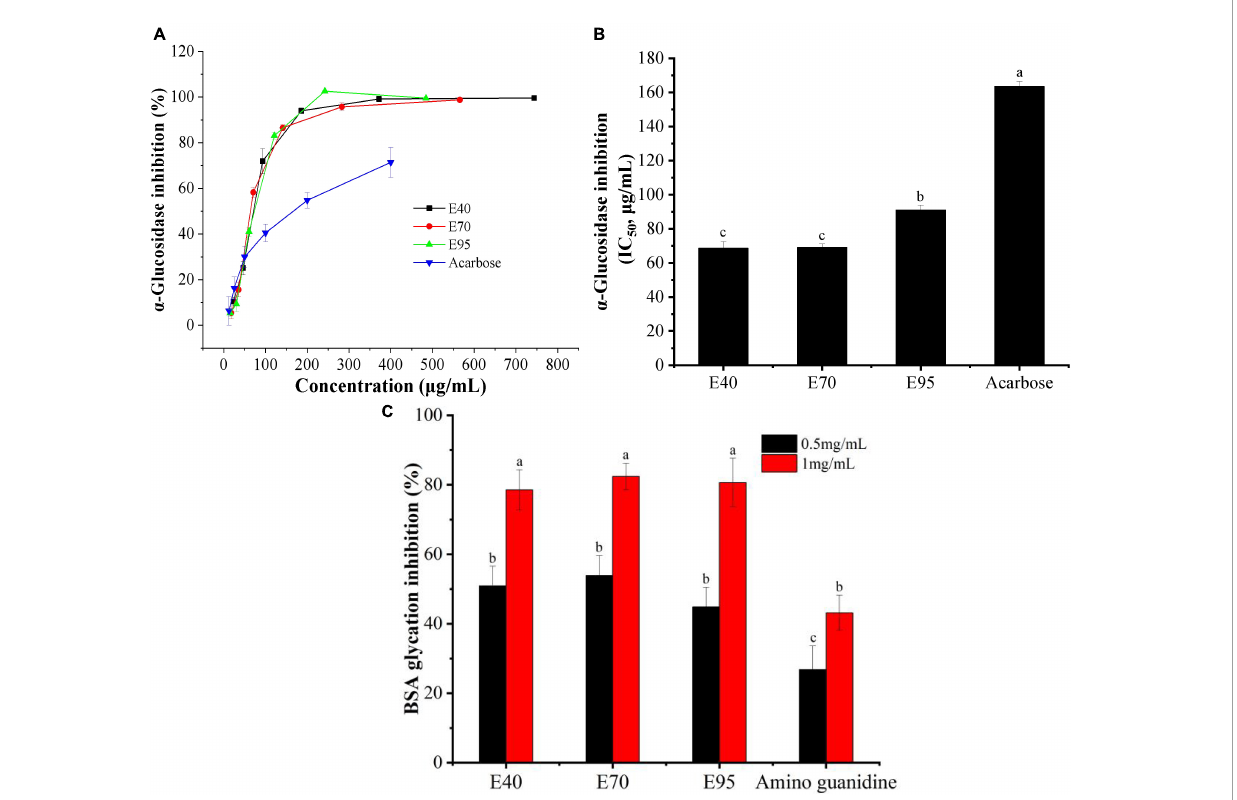
FIGURE4 The α -glucosidase inhibition (A) , IC 50 values for inhibiting α -glucosidase (B) , and anti-glycative ability (C) of PRA extracts. Different letters (a, b, c, etc.) upper each column indicate significant differences among the data ( P < 0.05).